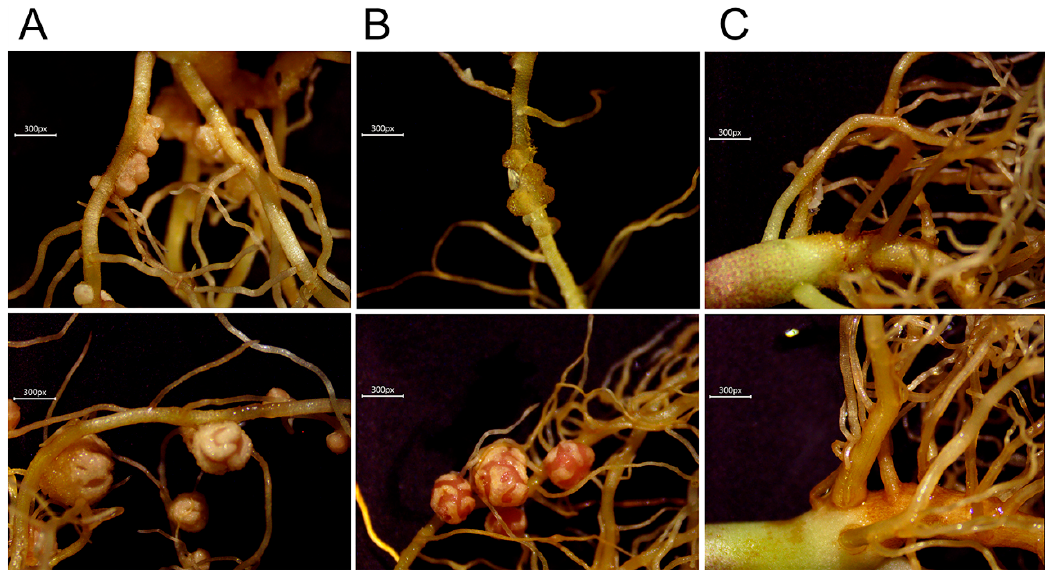
Figure 6. Phenotypes of early nitrogen-prefixing nodules and nitrogen-fixing root nodules (NFN) under different concentrations of nitrate with 0 mM ( A ), 5 mM ( B ) and 10 mM ( C ). Under each concentration, the top represents phenotype of early nitrogen-prefixing nodules and the bottom represent phenotype of NFN.